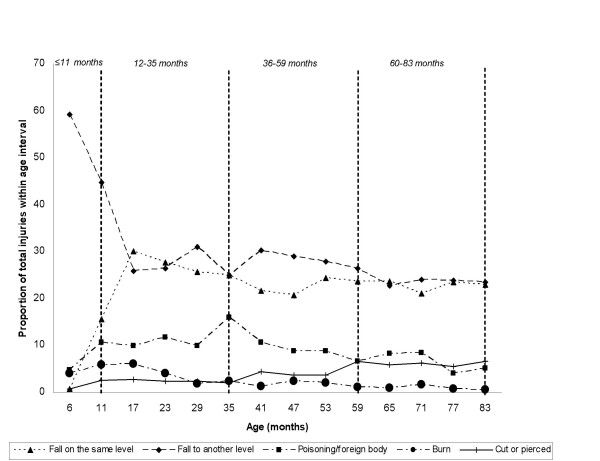
Profile of common external causes of paediatric injury within the early years.